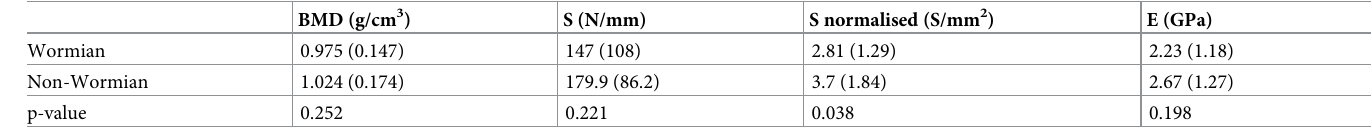
Table 2. Mean values (SD) for bone mineral density BMD, deflection (w), strain rate ( _ ε _ ), stiffness (S) and Young’s modulus (E) for the two group of equine parietal samples (Wormian and non-Wormian) tested in 3point bending.